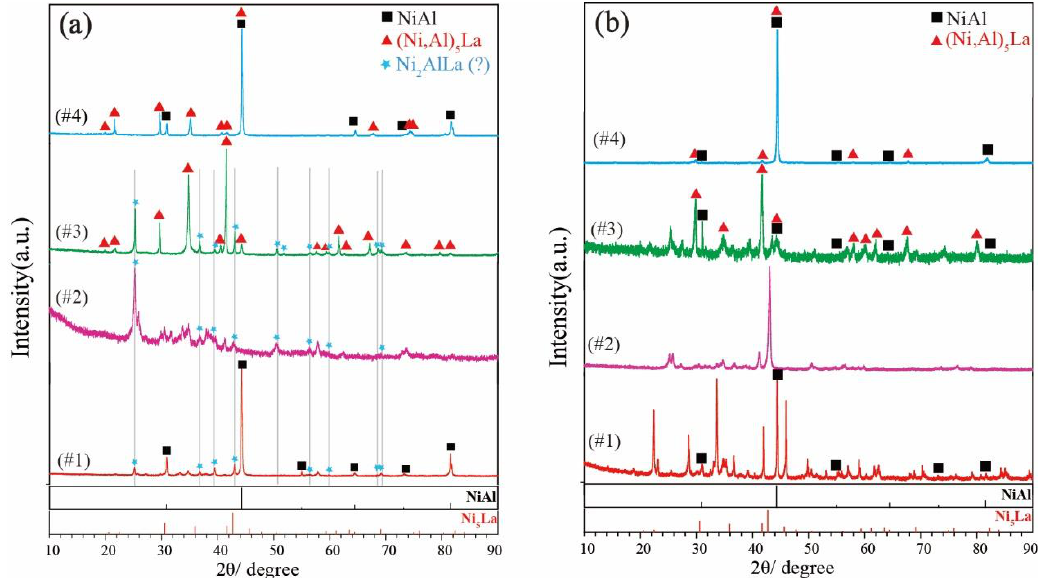
Figure 3. XRD patterns from: ( a ) Ni 50 Al 35 La 15 (#1), Ni 50 Al 18 La 32 (#2), Ni 57 Al 23 La 20 (#3) and Ni 60 Al 30 La 10 (#4) alloy annealed at 800 °C for 30 days; and ( b ) Ni 50 Al 35 La 15 (#1), Ni 50 Al 18 La 32 (#2), Ni 57 Al 23 La 20 (#3) and Ni 60 Al 30 La 10 (#4) alloy annealed at 1000 °C for 15 days. Table 3. Possible crystal structure of the Ni 2 AlLa intermetallic